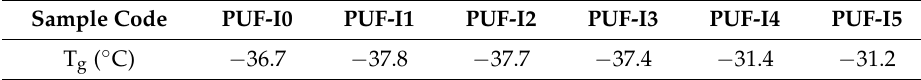
Figure 5. ( a ) Maximum rebounding height (%); ( b ) temperature dependence of storage modulus; ( c ) loss modulus; and ( d ) tan δ curves of the various FPUFs. Table 3. Glass transition temperature (T g ) of the various FPUFs determined by DMA.